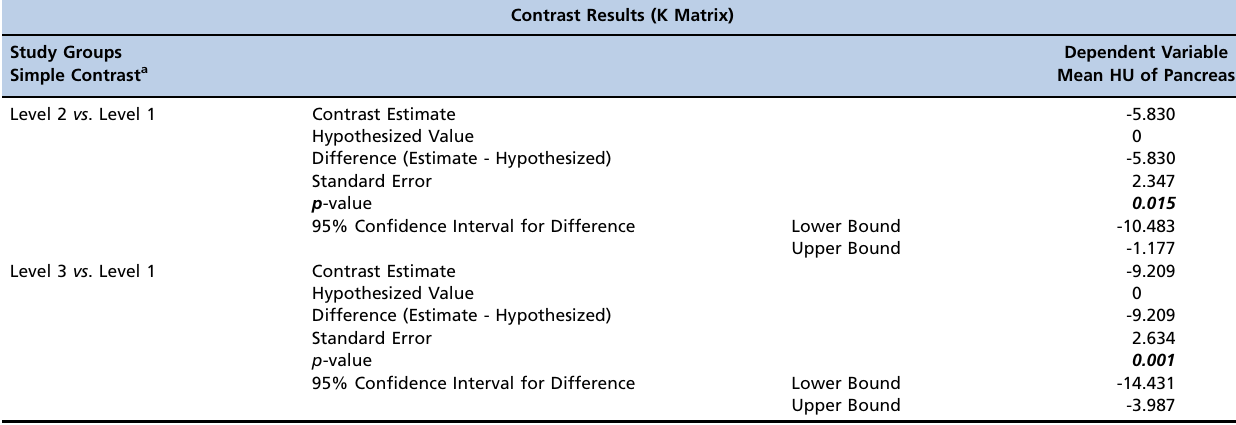
Contrast Results (K Matrix)